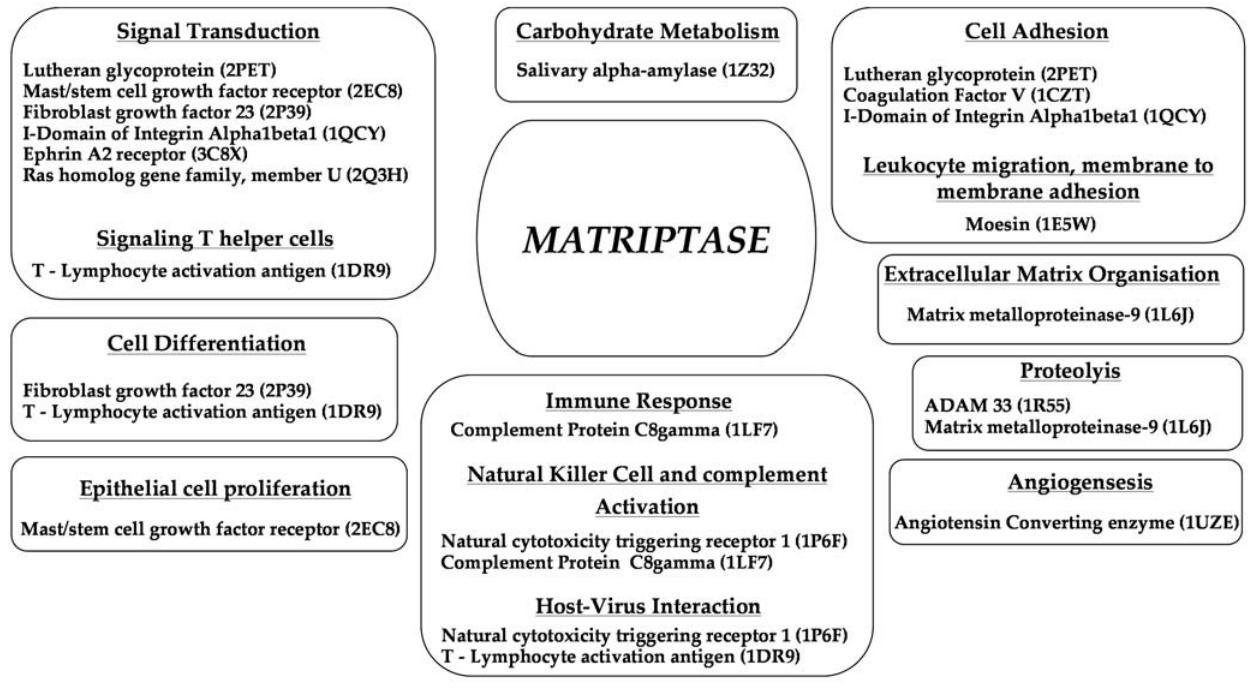
Figure 4. Assignment of functions to matriptase. Potential substrates of matriptase with rSASA $ 0.4 and with subcellular localization similar to matriptase were grouped based on their